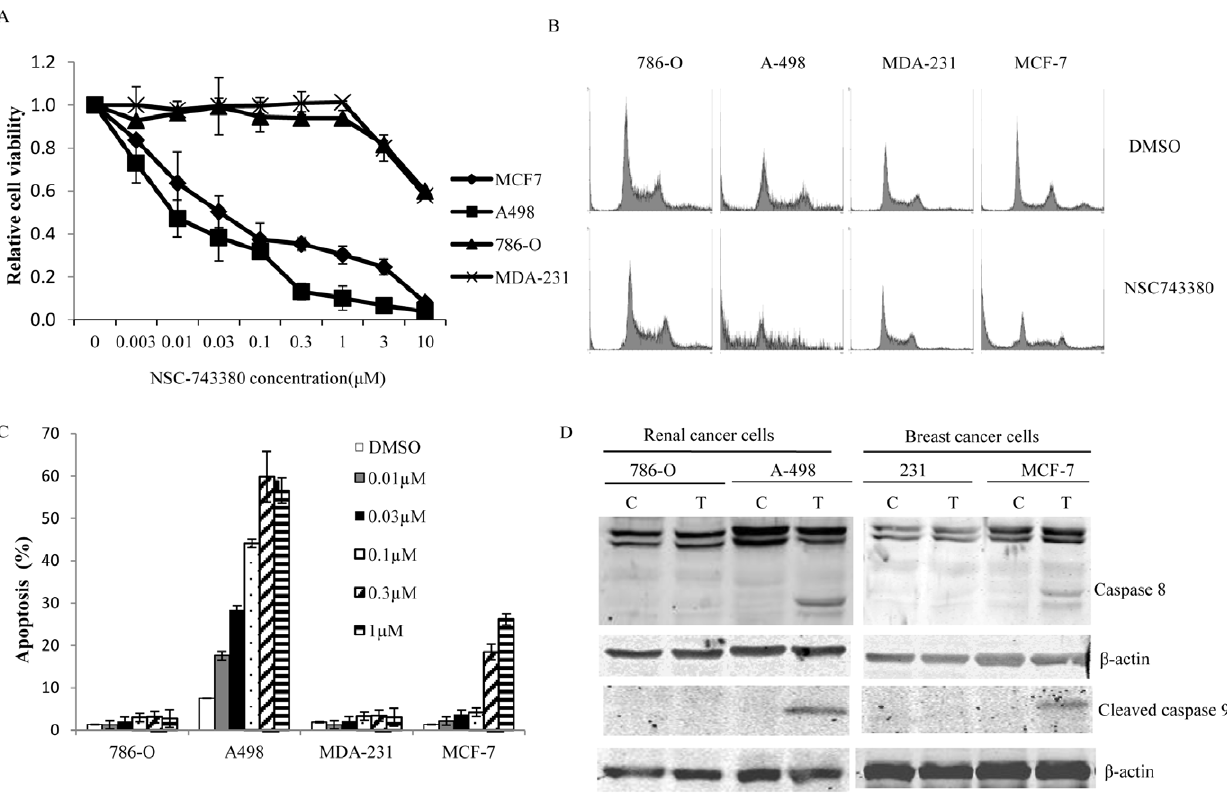
Figure 3. Induction of apoptosis by NSC-743380. Two renal cancer cell lines (786-O and A498) and two breast cancer cell lines (MCF-7 and MDA-MD-231) were treated with different doses of NSC-743380. Cells treated with DMSO were used as controls. Cell viability was assayed 72 h after treatment by the SRB method. Apoptotic cells were determined by flow cytometric analysis 24 h after treatment. A) Cell viability assay. Viability of control cells was set as 1. Each data point represents the mean 6 SD of three independent experiments. B) Histogram of cell cycle analysis at 24 h after treatment with 1 m M NSC-743380. C) Percentages of apoptotic cells. The values represent the means 6 SD of three analyses. D) The four cell lines were treated with 1 m M NSC-743380 for 12 h. Whole-cell lysates were harvested for Western blot analysis of caspase-8 cleavage and